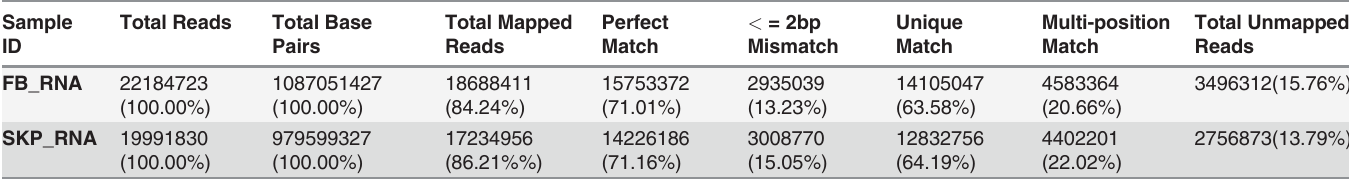
Table 2. Summary of mapping results(mapping to reference genes).